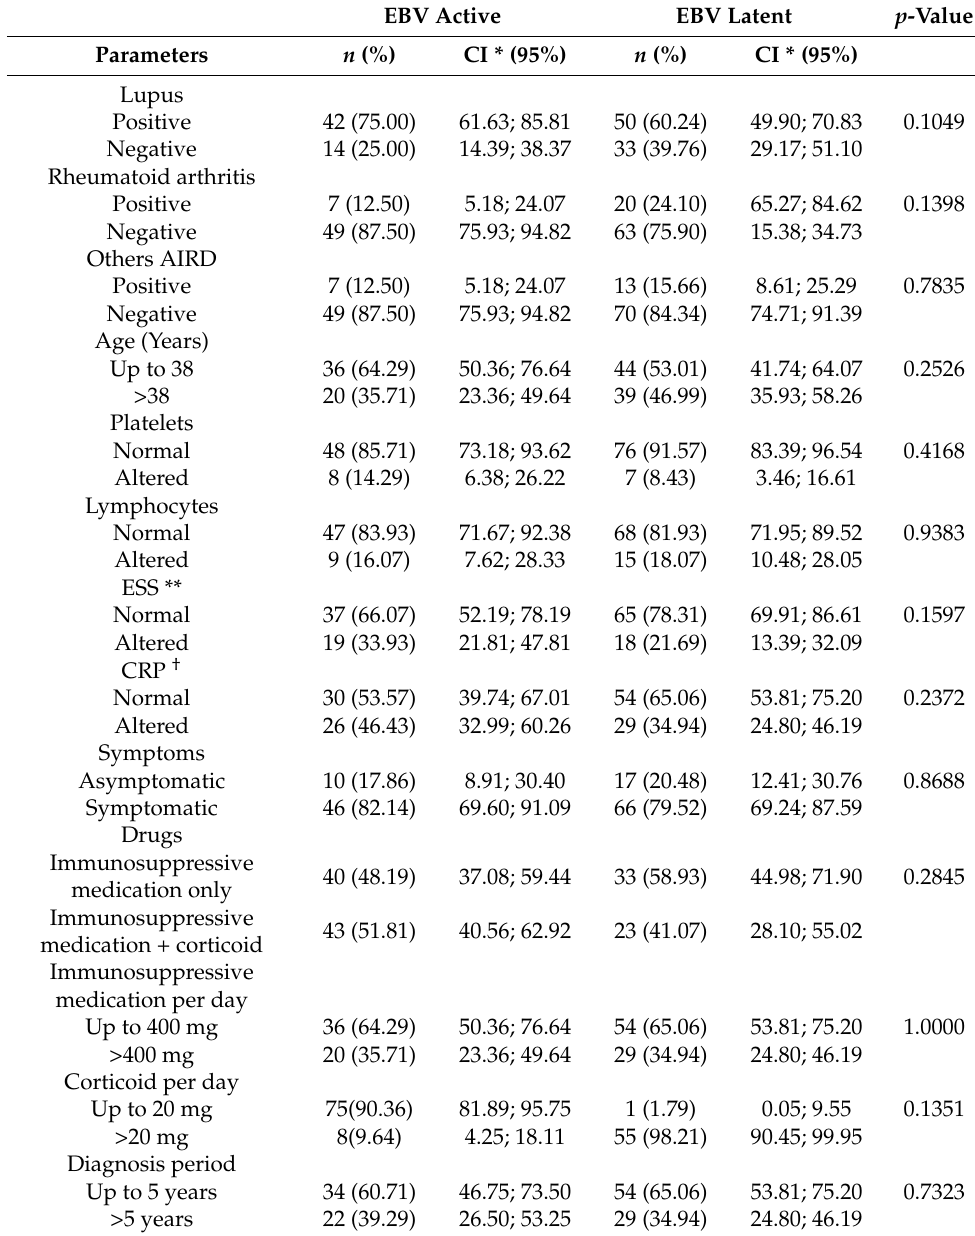
Table 2. Clinical, laboratory and therapeutic characteristics according to the profile of EBV infection in autoimmune diseases.